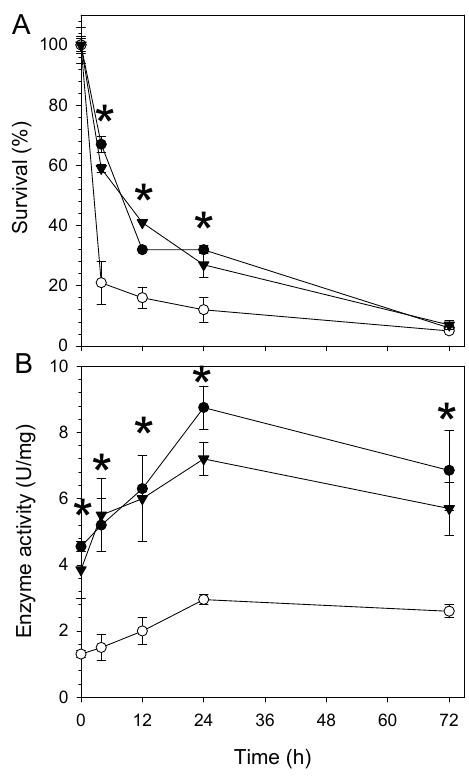
Figure 2. Effect of desiccation-induced stress on ( A ) survival of the three B. japonicum strains (wild type, aceA mutant WC2455, and aceA complemented strain WC2455-C) and ( B ) their ICL enzyme activities. One unit of ICL activity was defined as the amount of enzyme required to produce 1 μ mol of glyoxylate per min at pH 6.8 and 30 °C. Symbols: ● , wild type; ○ , WC2455; ▼ , WC2455-C. Asterisks indicate significant differences between the wild type and mutant strains using t -test ( p <